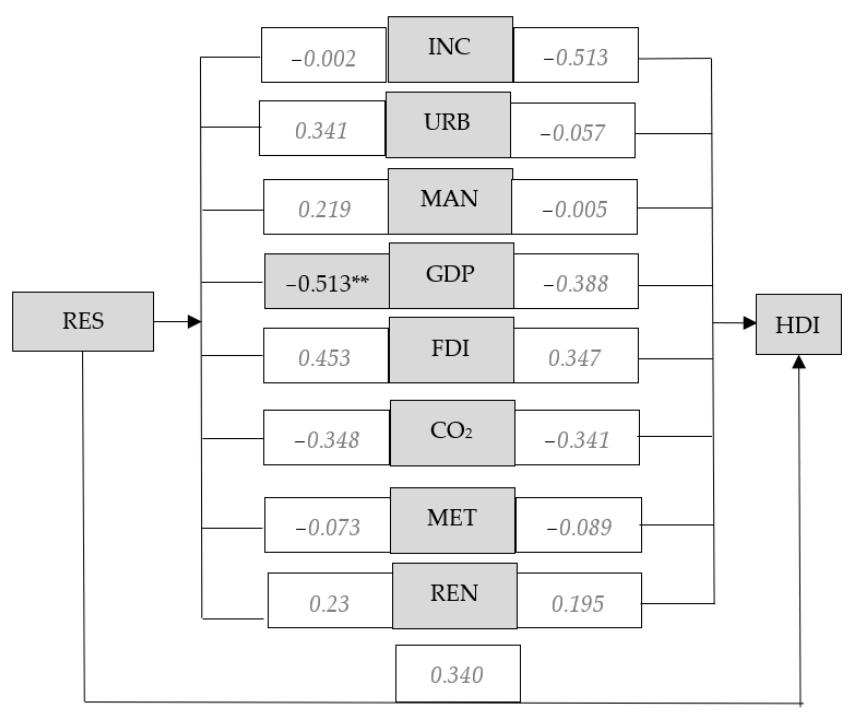
significance level, and *** 1% significance level.